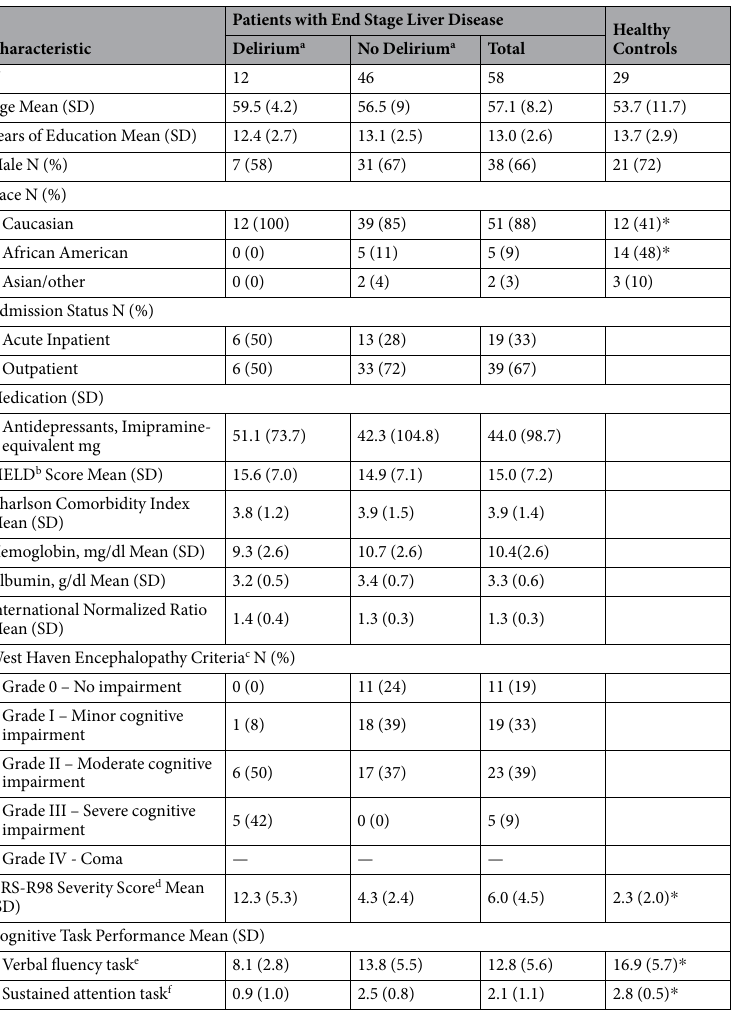
Table 1. Demographic and illness severity characteristics of study participants. a As measured using the Confusion Assessment Method (CAM). b MELD, Model for End-stage Liver Disease score. c Severity of